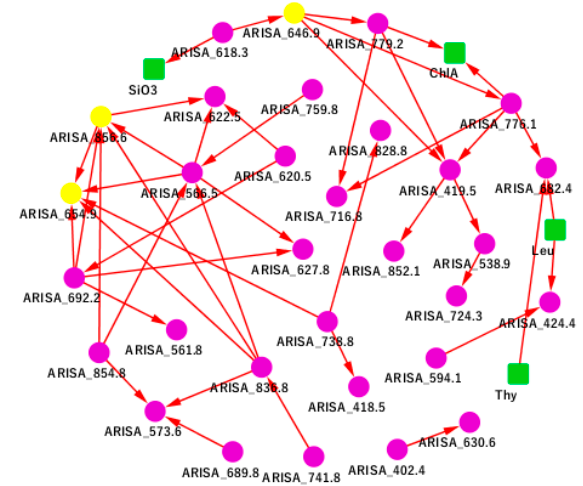
Figure 1. The San Pedro Ocean Time-Series (SPOT) Granger causality network. A green square represents an environmental factor, including ChlA, Leu, SiO3, and Thy. A purple circle represents an operational taxonomic unit (OTU). A yellow circle represents a highlighted key OTU which was discussed in the main text. The directed edge A → B represents A Granger causes B.